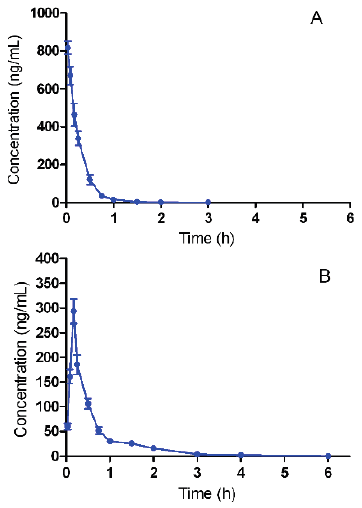
Figure 3. The pharmacokinetic profiles of triptolide in rats after of intravenous administration of triptolide ( A ) at a dosage of 1 mg/kg and oral administration of triptolide ( B ) at 1